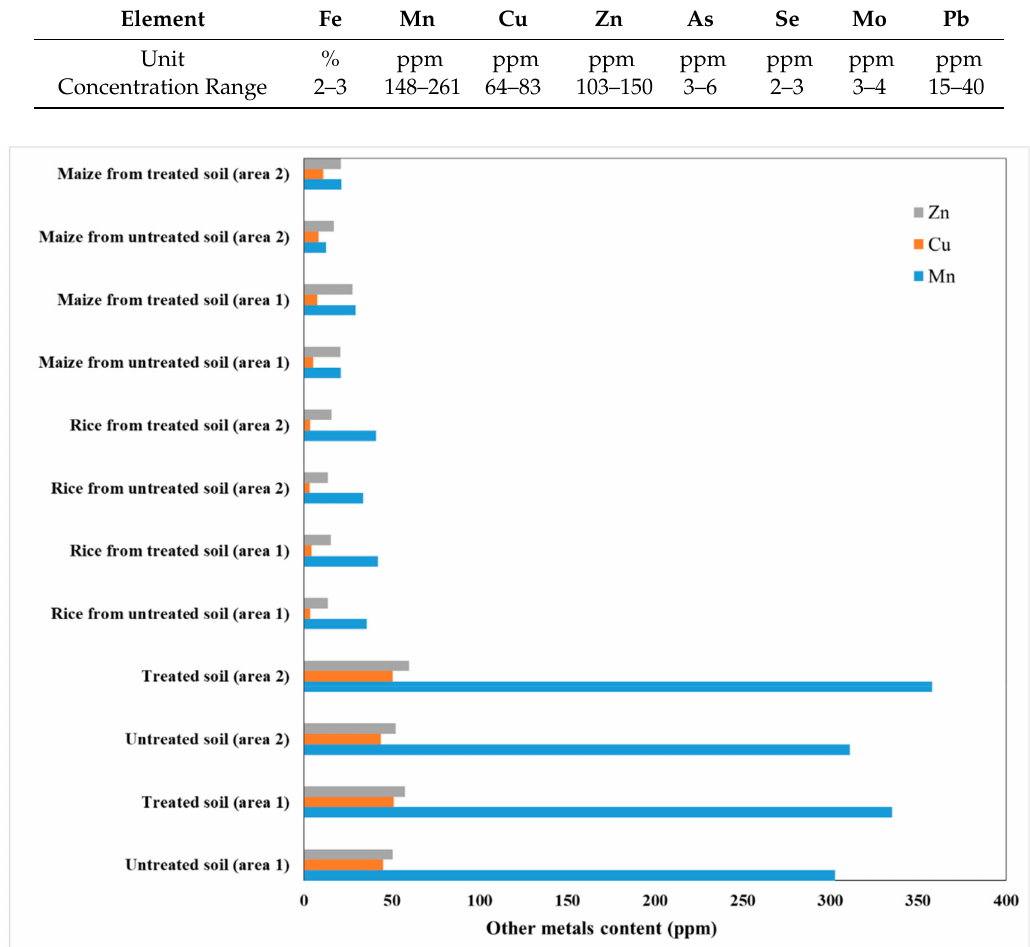
Table 1. The elemental composition of the fly ash.